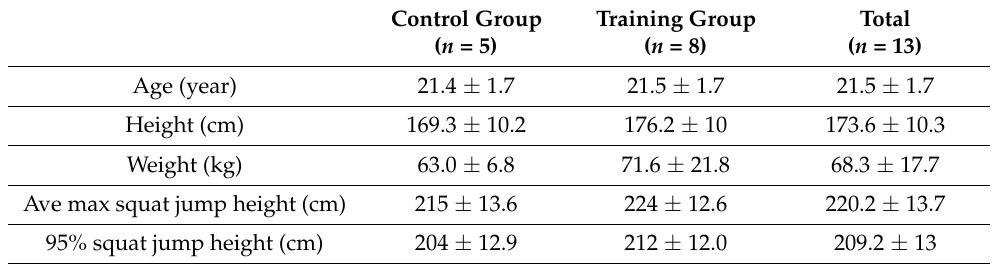
Table 1. Subject